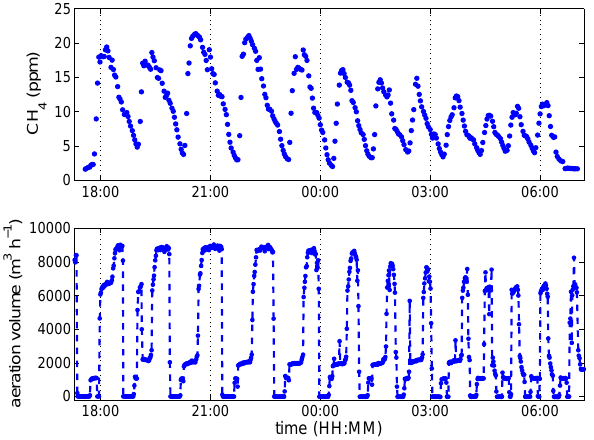
Figure 5. Comparison of CH 4 concentrations from the LSCE FTIR and CRDS analyzers during the night of 20 September.